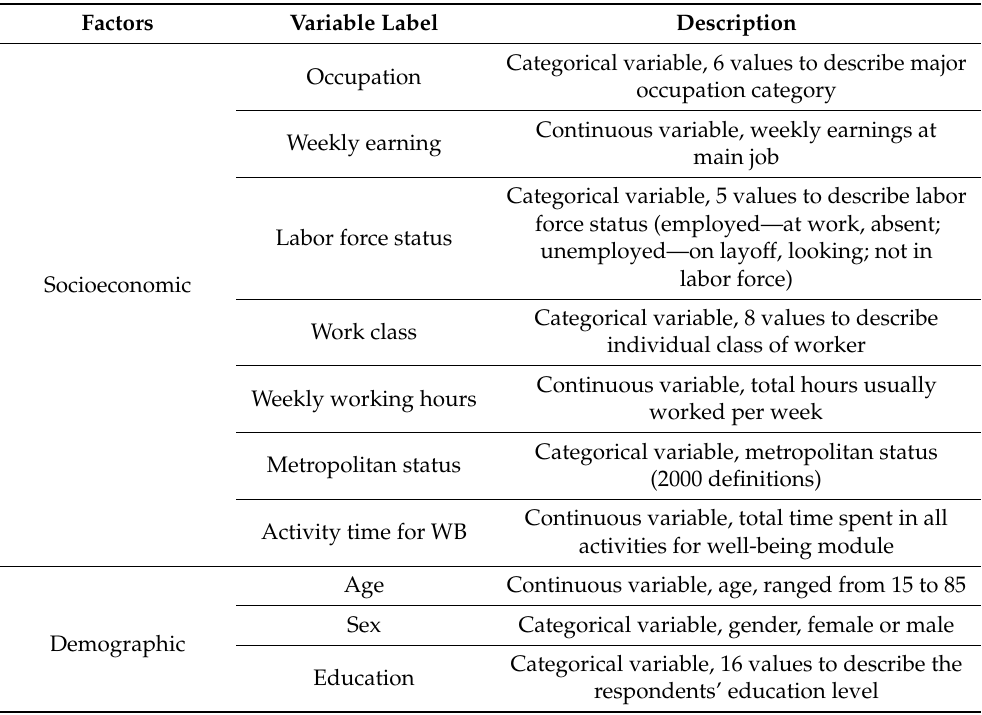
Table 1. Description of socioeconomic, demographic, and travel